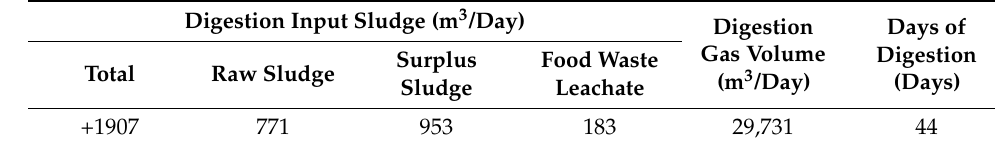
Table 2. The operation status of the wastewater treatment plant (2018).